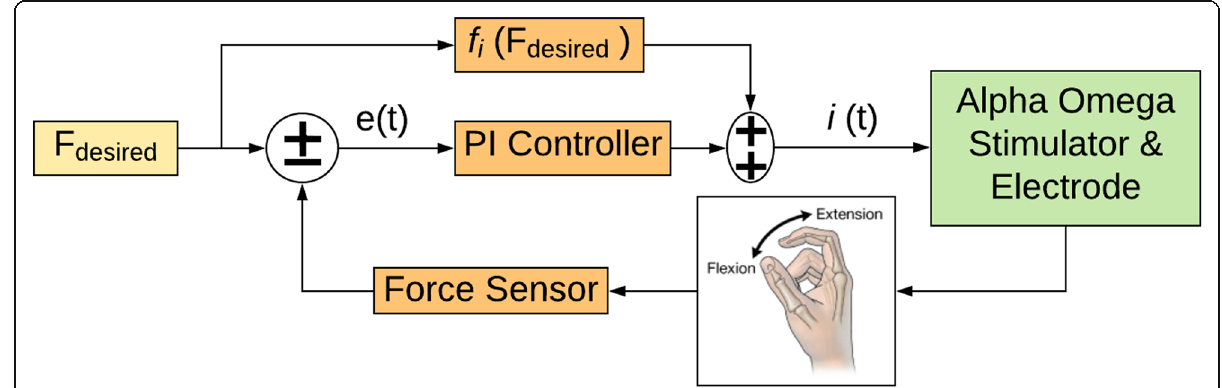
Fig. 2 The feedforward-feedback control architecture included a feedforward block (f i ) which uses the desired force (F desired ) as an input to produce a computed current output. The output of the feedforward block is added to the feedback controller output and this sum is provided to the Alpha Omega Stimulator as the command input. The feedback controller is a proportional-integral (PI) type, providing current commands to the Alpha Omega